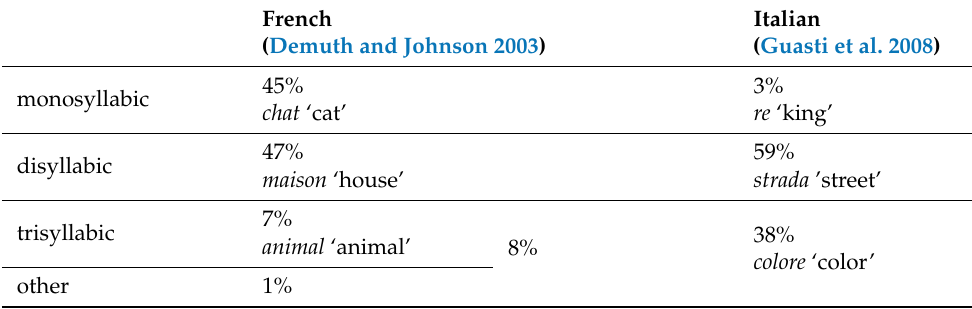
Table 2. Length of (prosodic) words in French and